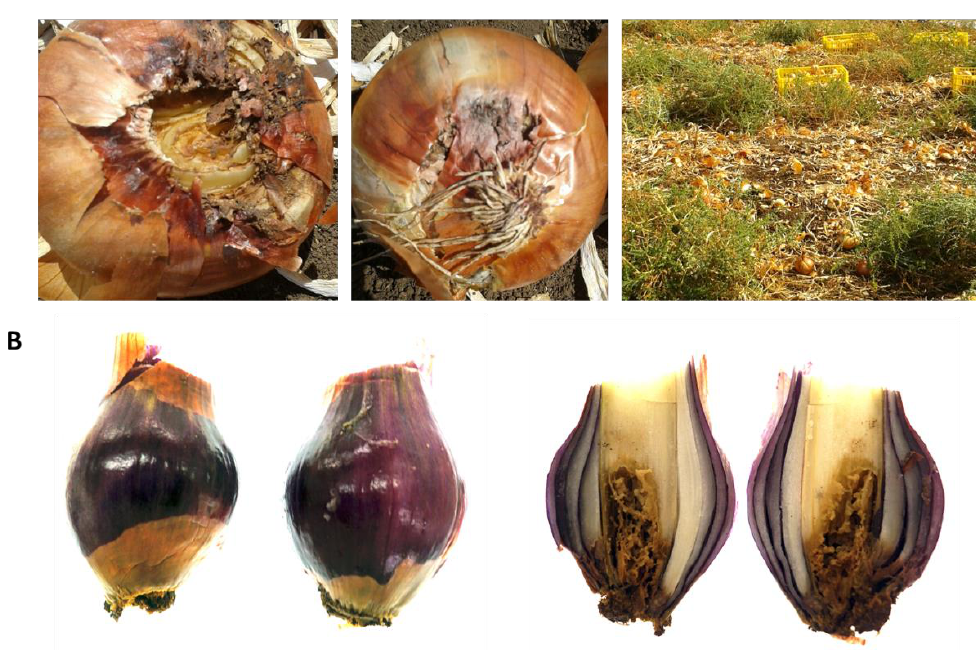
Figure 2. Onion bulb symptoms. ( A ) Basal rot symptoms appear on the Riverside cv. on the harvest day (30 August 2017, approximately 80 days from sowing) in the commercial field, presented in Figure 1. The two pictures on the left are a closeup of the symptoms, and the 3rd image is a wide view of the field from which these bulbs were collected. The density of the onion bulbs in the area may have facilitated disease spread. ( B ) Symptoms of basal rot on red onion, 565 / 505 cv., a newly developed cultivar from Hazera Seeds Ltd., Israel, collected from a commercial field near Moshav Eliad (southern Golan Heights, northeastern Israel) on the harvest day on 23 May 2018 (approximately 80 days from sowing).